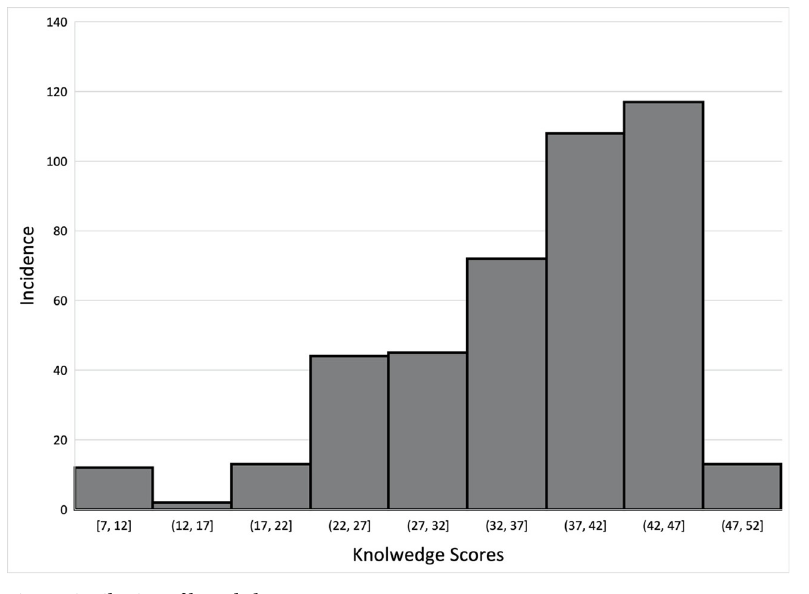
Fig 2. Distribution of knowledge scores.